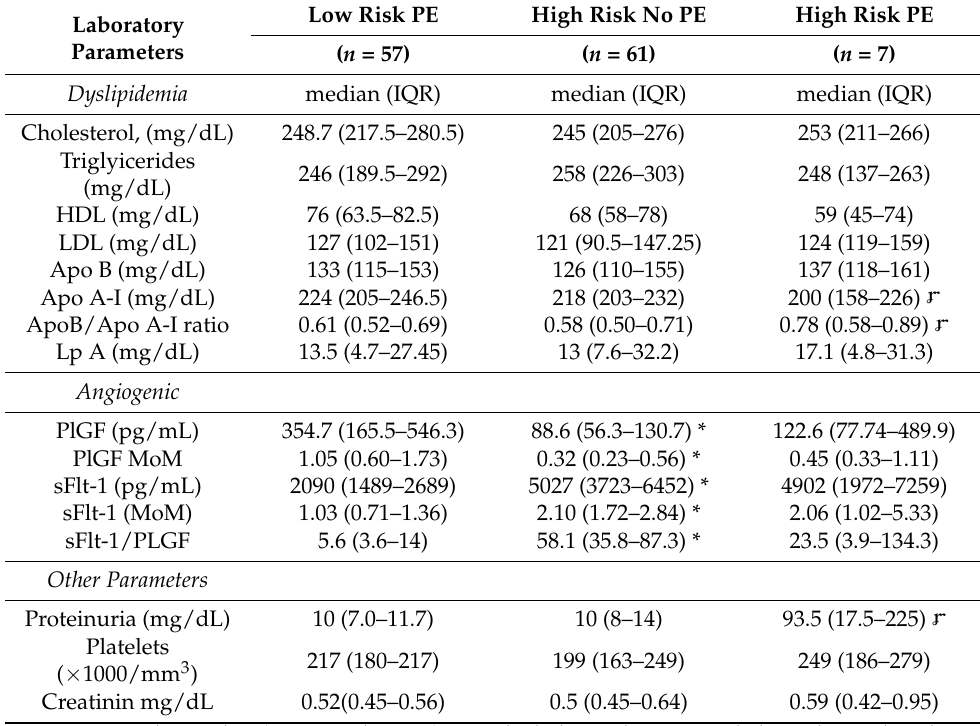
Table 2. Laboratory data in pregnant women at low risk, high risk, and term PE.